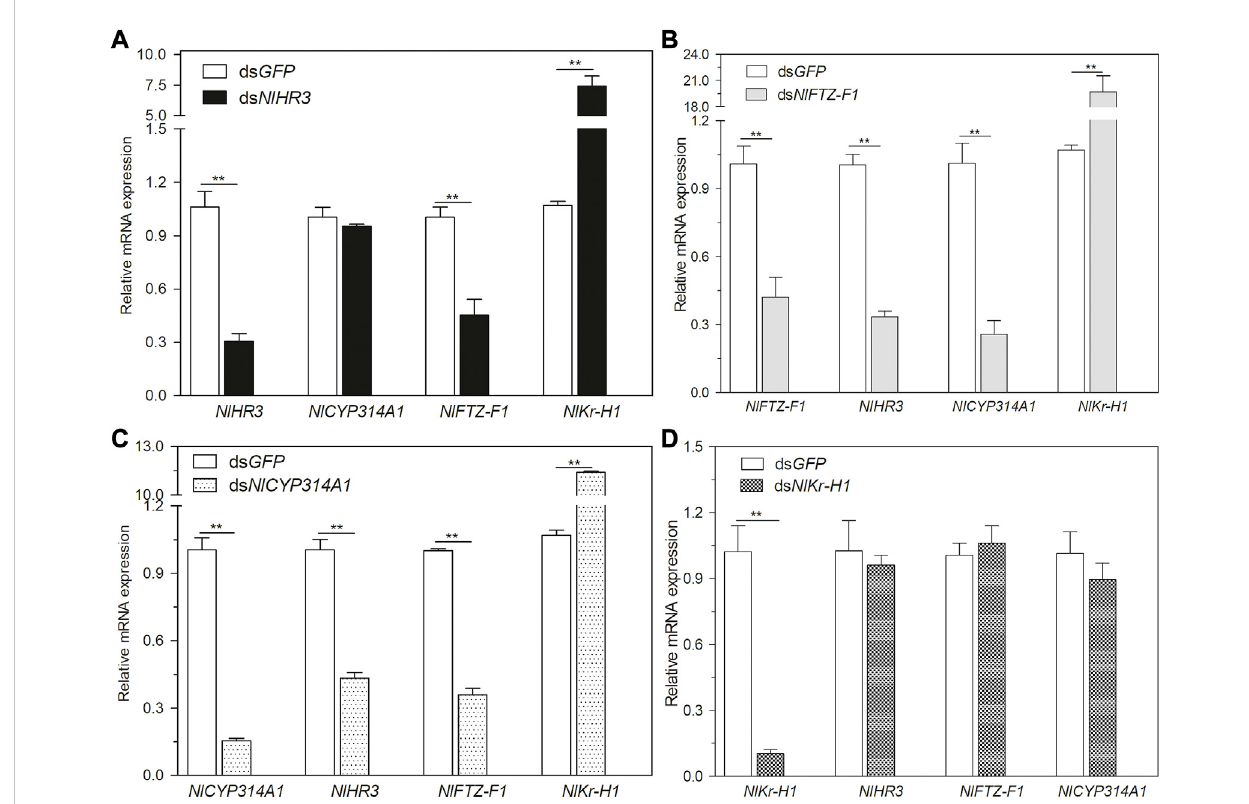
FIGURE 3 Relationship between NlHR3 , NlFTZ-F1 , and the hormone signaling pathway. (A) Downregulation of NlHR3 affected 20E and JH signaling pathway gene expression. (B) Downregulation of NlFTZ-F1 affected 20E and JH signaling pathway gene expression. (C) Downregulation of NlCYP314A1 affected NlHR3 and NlFTZ-F1 expression. (D) Downregulation of NlKr-H1 did not affect NlHR3 and NlFTZ-F1 expression. The SE was determined from three independent biological replicates, each with three technical replications. ** indicates a signi fi cant difference at a p -value < 0.01 (Student ’ s t